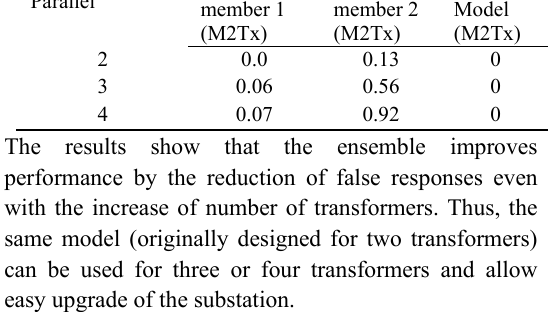
Table 4: Percentage of false responses by Ensemble model (M2Tx) when number transformers are increased Number of